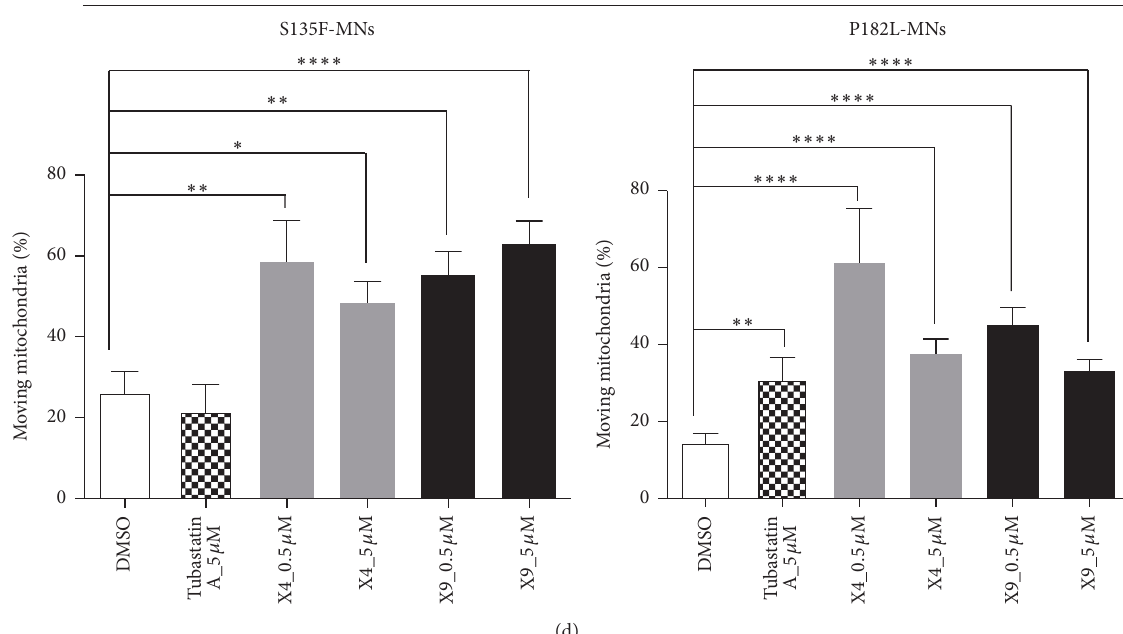
Figure 5: HDAC6 inhibitors reversed axonal defect of mitochondrial transport by increasing acetylation of 𝛼 -tubulin. (a and b) Western blot assay showed that treatment of HDAC6 inhibitors increased acetylated 𝛼 -tubulin levels in S135F-MNs and P182L-MNs (paired 𝑡 -tests, ∗ 𝑃 < 0.05 and ∗∗ 𝑃 < 0.01 ). (c) HDAC6 inhibitors increased the absolute velocity of mitochondrial movements in S135F-MNs and P182L- MNs (WA09-MNs; 𝑁 = 617 , S135F-MNs; 𝑁 = 101 , and P182L-MNs; 𝑁 = 394 ). (d) HDAC6 inhibitors increased the percentage of moving mitochondria in S135F-MNs and P182L-MNs (WA09-MNs; 𝑁 = 15 , S135F-MNs; 𝑁 = 7 , and P182L-MNs; 𝑁 = 15 ). Unpaired 𝑡 -tests, ∗ 𝑃 < 0.05 , ∗∗ 𝑃 < 0.01 , and ∗∗∗∗ 𝑃 < 0.0001